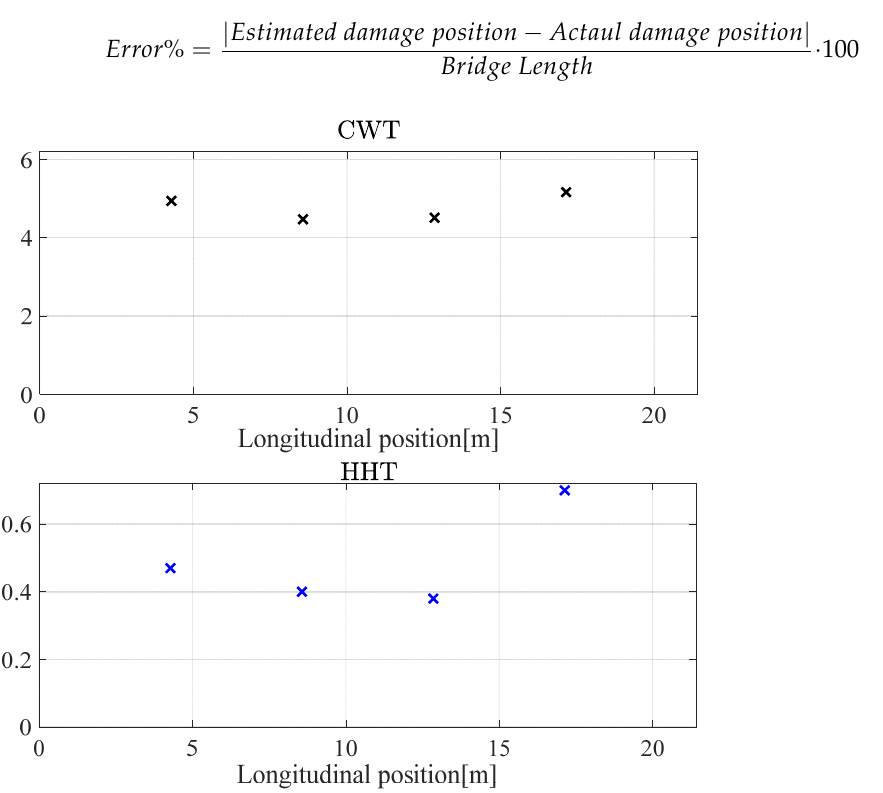
Figure 18. Trend of coefficients maximum magnitudes as function of damage position. CSA train travelling at 100 km/h, and no track irregularity.